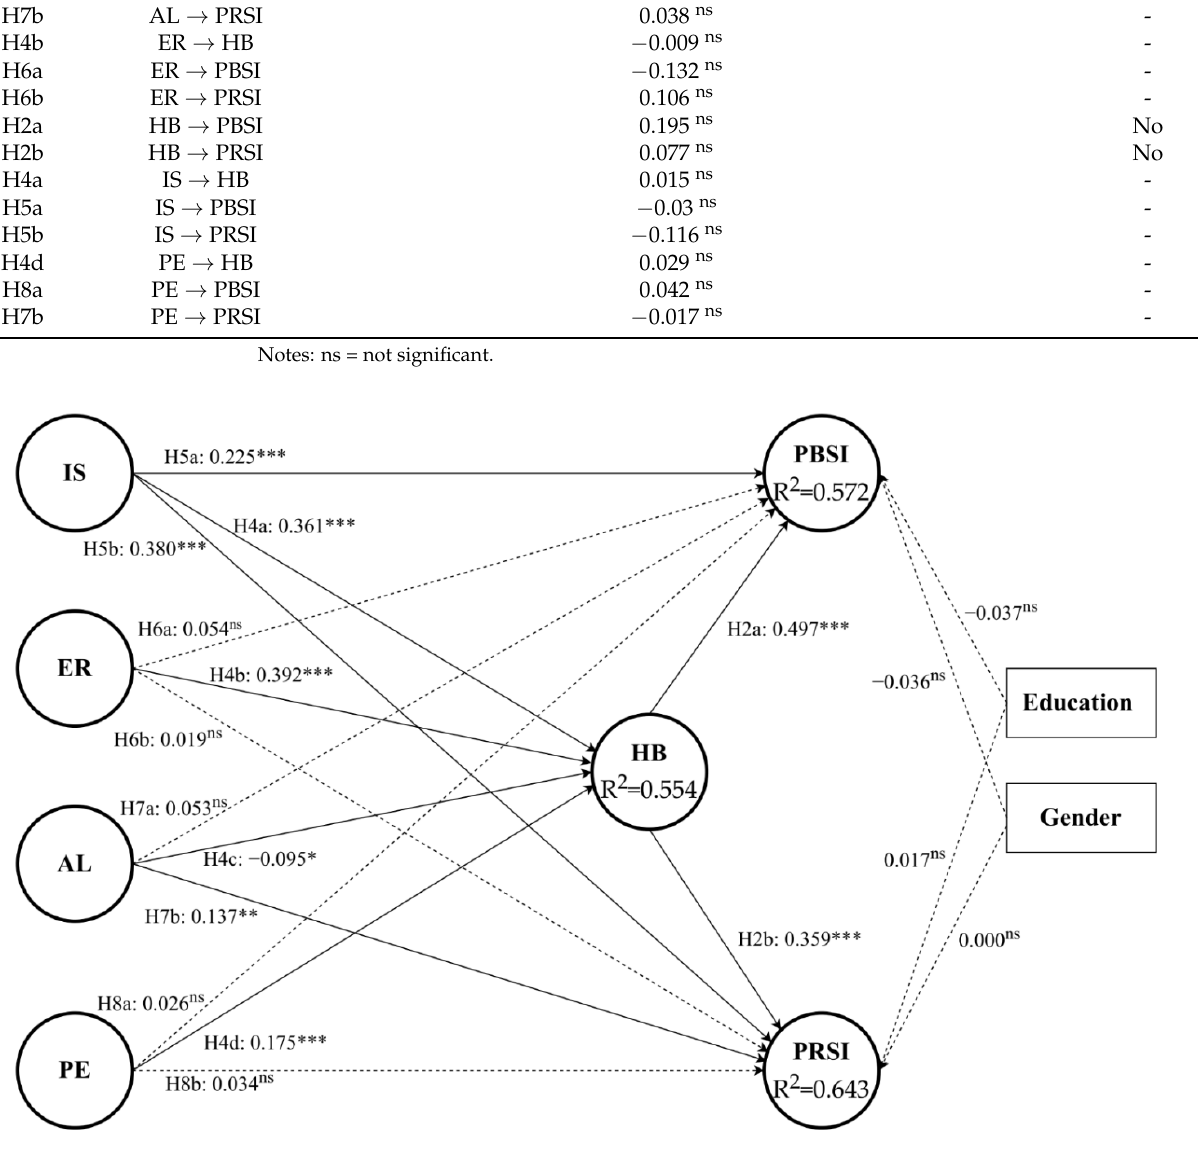
Figure 1. Results of the structural model analysis. Notes: * p < 0.05, ** p < 0.01, *** p < 0.001, ns = not significant.